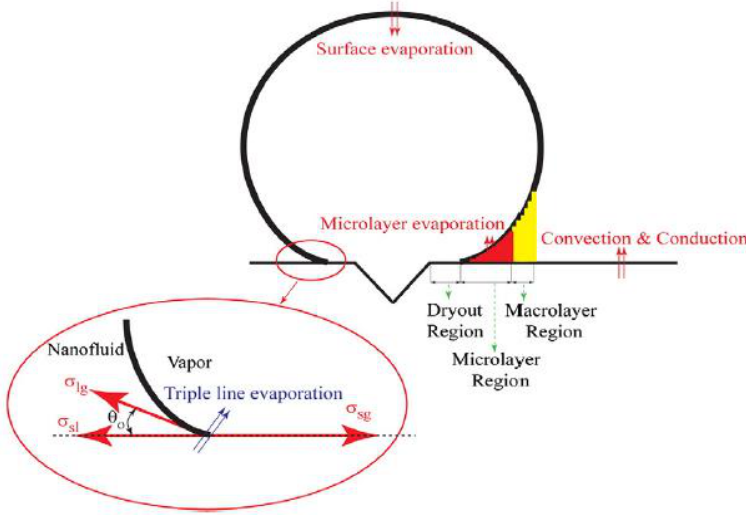
Figure 10. These two aspects cause a decrease in the boiling heat transfer coefficient.